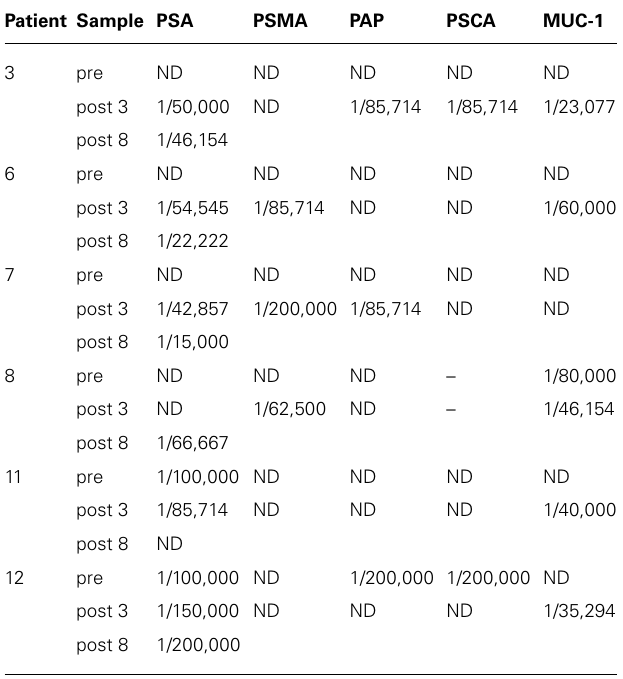
Table 1 | Immune responses following treatment with poxviral vaccines expressing PSA and B7-1 in combination with EBRT and low-dose IL-2 (Gulley etal.,